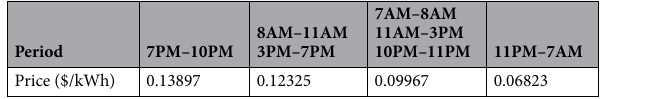
Table 3. Electricity price.